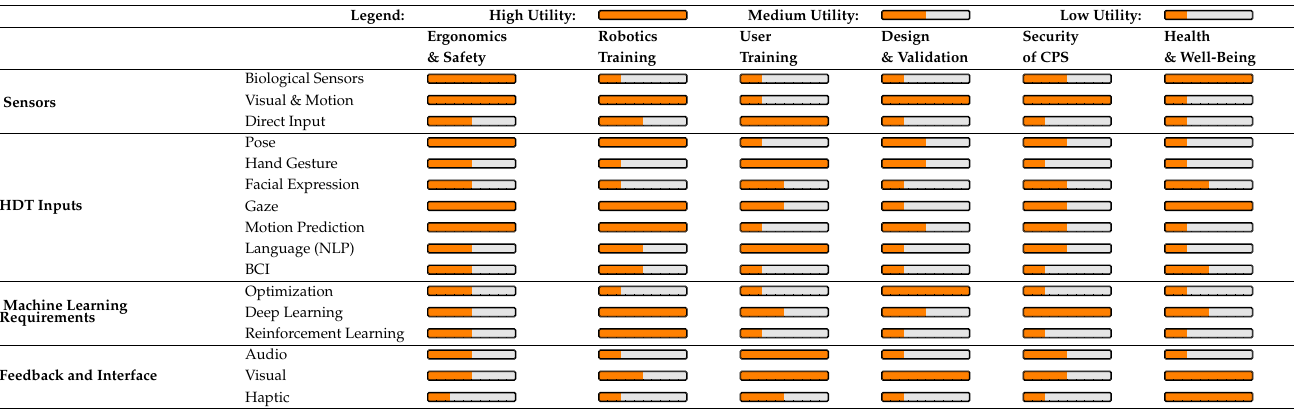
Table 9. Guidelines for enabling technologies in application